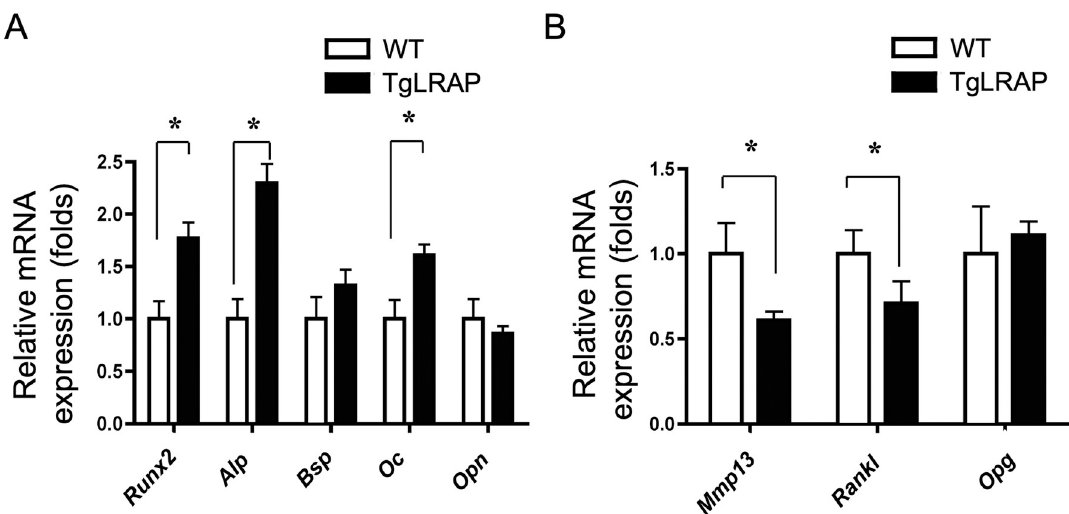
Fig 4. Altered gene expression levels in LRAP transgenic calvarial cells using Q-PCR. The empty or solid column represents the mRNA expression of WT or TgLRAP calvarial cells examined, respectively. A , Bone formation markers. B, Bone resorption makers. The experiments were repeated 3 times. Each column represents the mean ± SD. � p < 0.05. WT; wild-type mouse, TgLRAP; LRAP transgenic